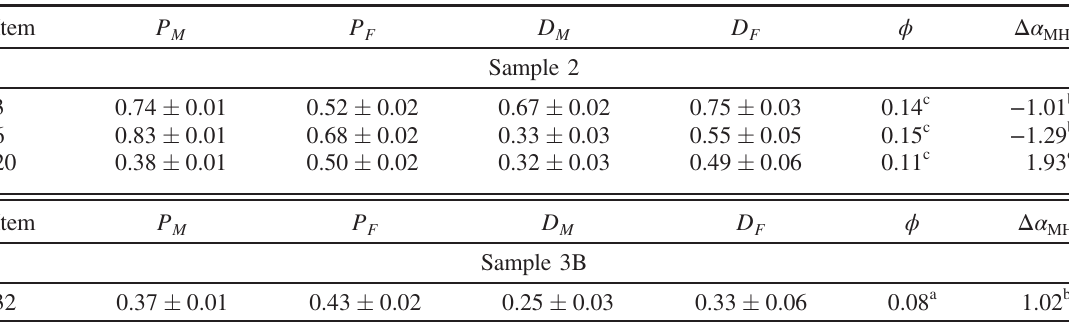
TABLE VIII. CTT difficulty and discrimination and DIF Δ α large DIF. The significance levels have been Bonferroni corrected: “ a ” denotes p < 0 . 0016 , “ b ” denotes p < 0 . 0003 , and “ c ” denotes p < 0 . 00003